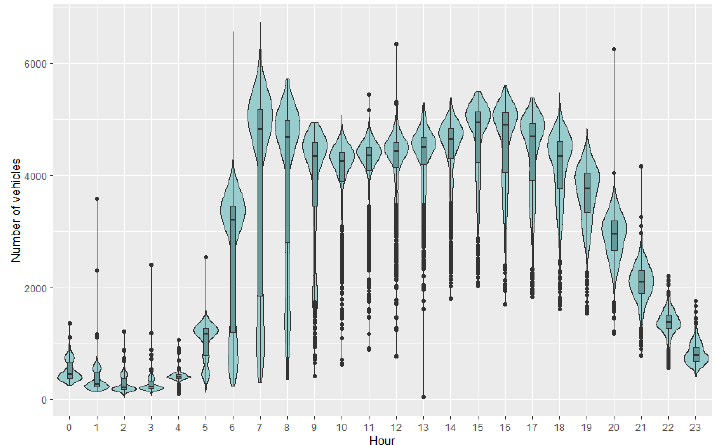
Figure A1. Traffic daily variability in analyzed period 2015–2017.